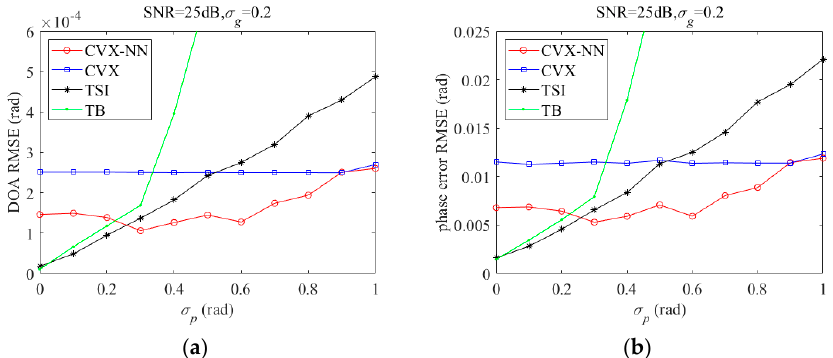
Figure 6. Estimated DOA and phase error RMSE versus σ p : ( a ) DOA; ( b ) phase error.